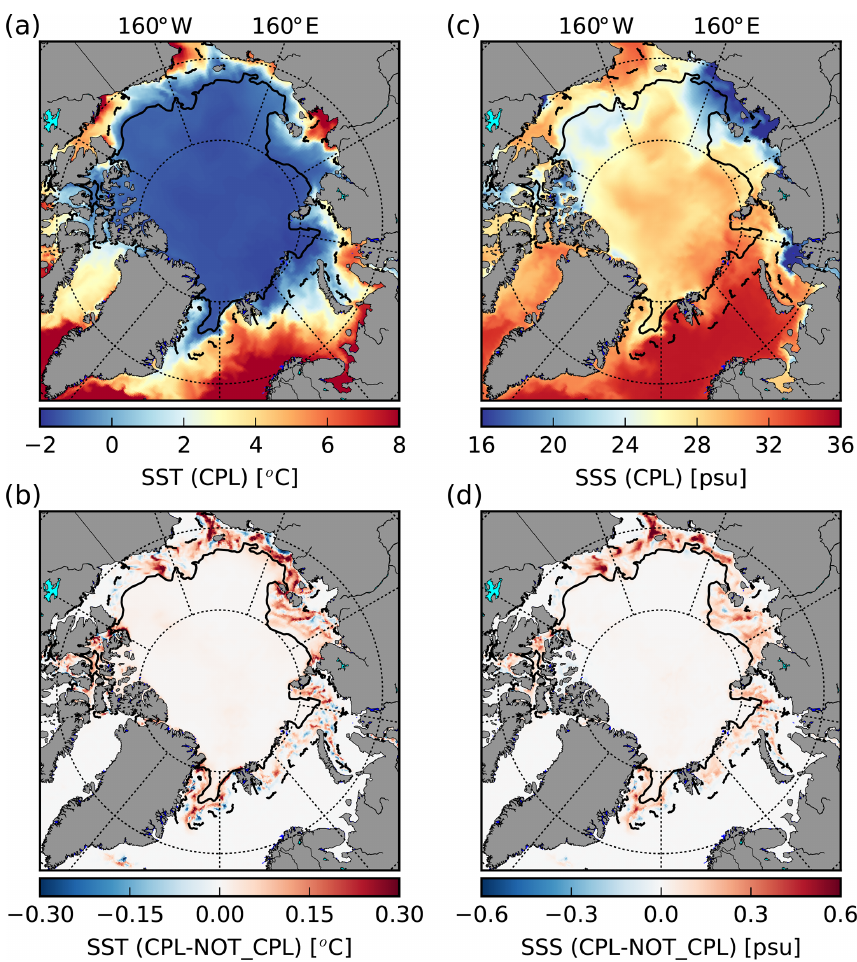
Figure 9. SST (a) and SSS (c) in the CPL run for the period between 4 August and 9 September 2010 and the difference with NOT_CPL (b, d) . The black contours delimit the MIZ in the CPL simulation, defined here as 0 < (cid:104) D max (cid:105) <